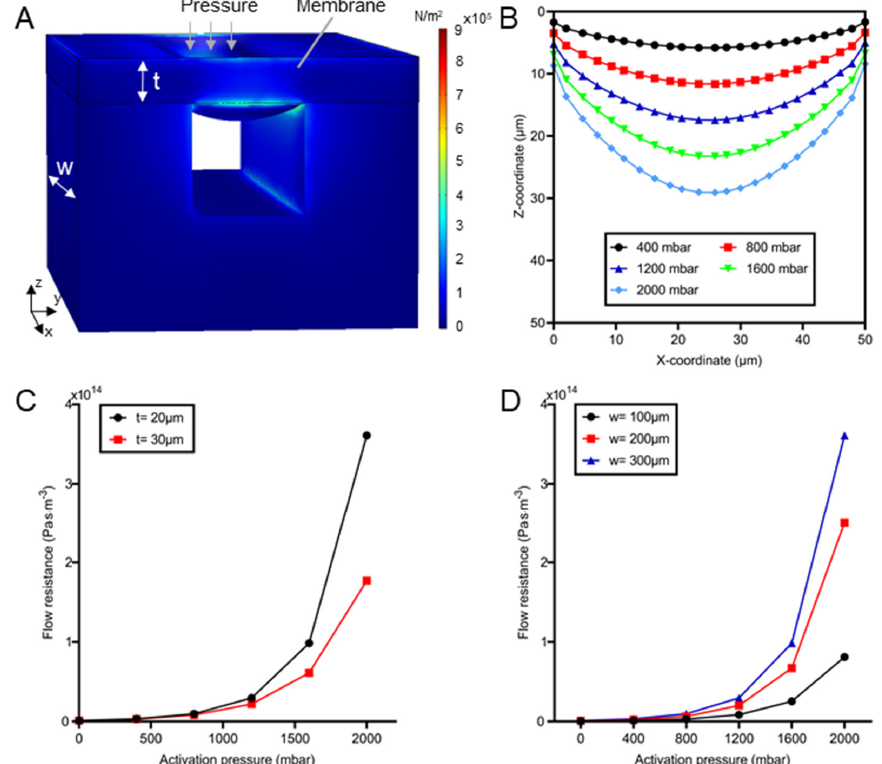
Figure 3. Study of the deformation and resulting flow resistance of pneumatic microvalves. ( A ) A 3D model of a microvalve. The width and the thickness of the membrane are represented by w and t, respectively. Color legend indicates the surface stress. ( B ) The cross-sectional profile of the membrane deflected at various pressure when w = 300 µm and t = 20 µm. ( C ) The flow resistance as a function of activation pressure for a valve with different membrane thicknesses and fixed width (300 µm). ( D ) The flow resistance as a function of activation pressure at different valve widths and a given membrane thickness (20 µm).